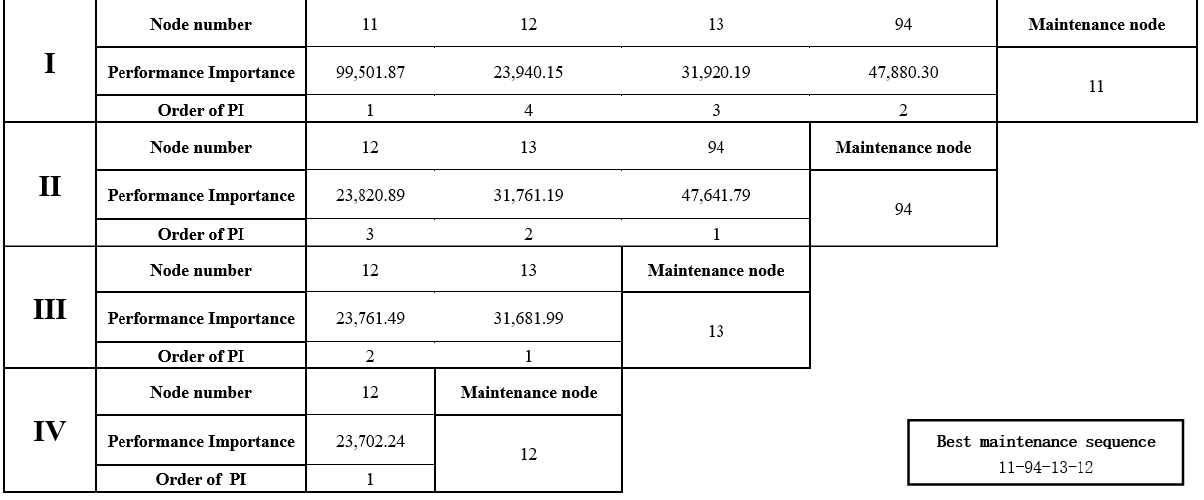
Figure 10. Optimal maintenance order based on node importance.